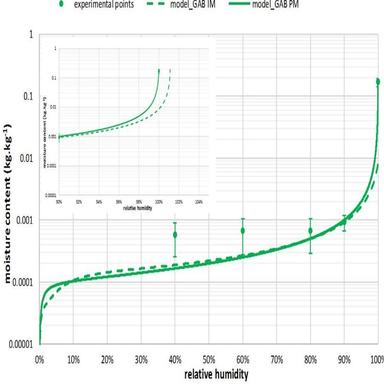
Comparison between the experimental data and the predictive sorption isotherm at 23 C. The figure in the top left corner is an enlargement of the curves from 90 to 105%RH.